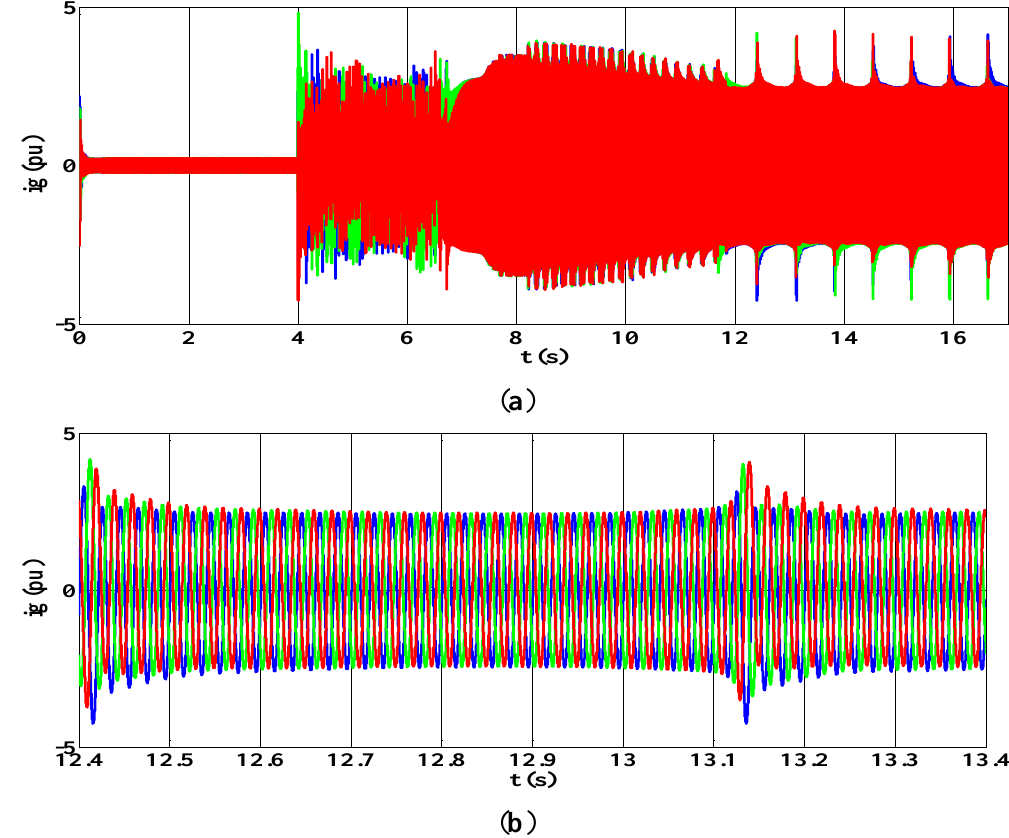
Figure 13. ( a ) Grid Side Converter (GSC) phase currents I gabc (short-circuit happens at t = 4 s), ( b ) zoom of (a).